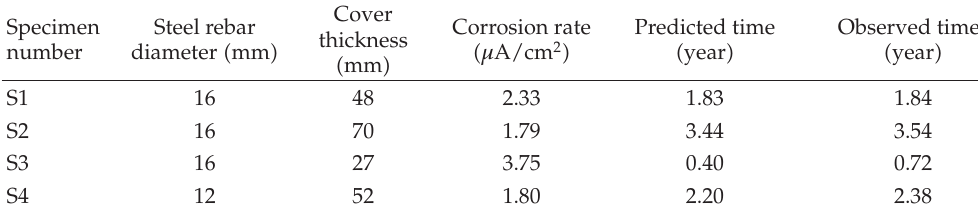
Table 1: Predicted and observed times to cracking on concrete cover surface.